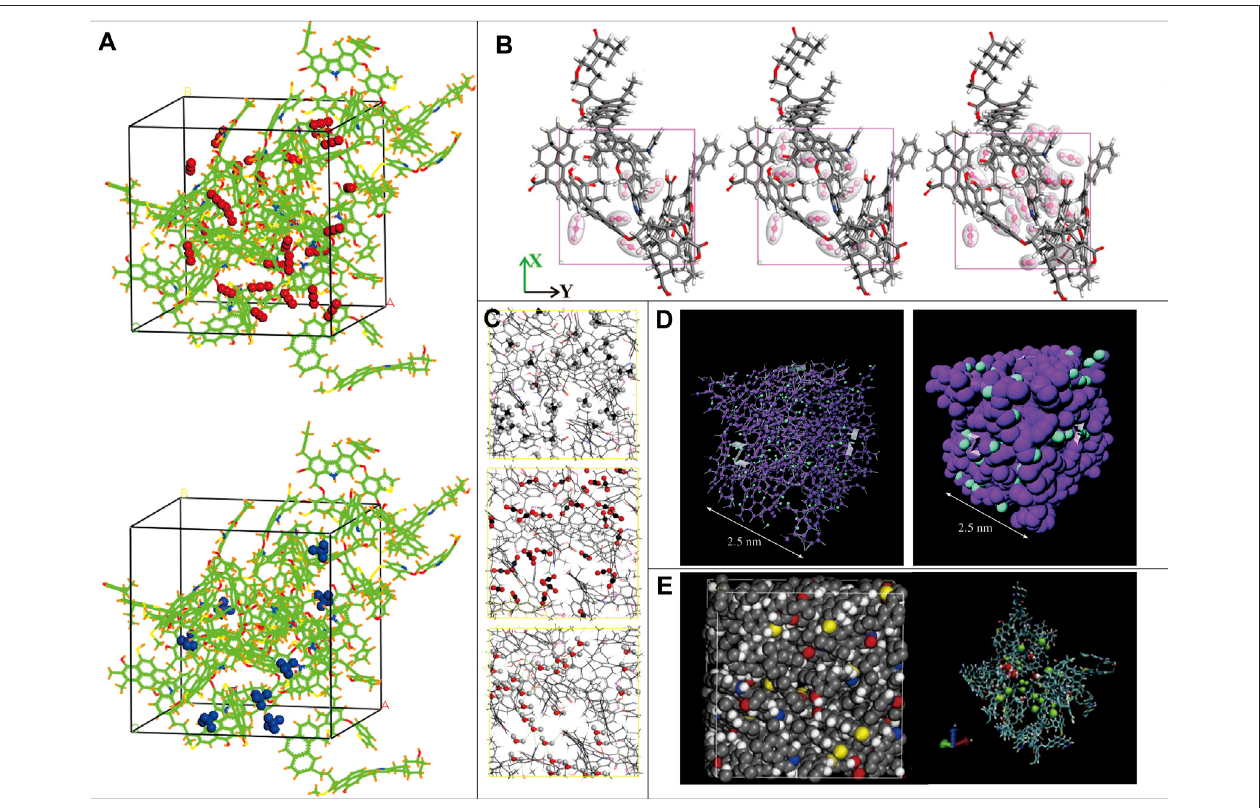
FIGURE 5 | Typical coal macromolecular representations used to simulate the adsorption process (A) : Wiser model absorbing the CO 2 and CH 4 (Zhao et al., 2016b); (B) : the typical vitrinite model absorbing different amounts of CO 2 (Song et al., 2018); (C) : the Yanzhou coal model absorbing CH 4 , CO 2 , and H 2 O (Xiang et al., 2014); (D) : CS1000 coal model absorbing CO 2 (Brochard et al., 2012); (E) : intermediate-rank bituminous coal building block absorbing H 2 O and CH 4 (Zhang et al., 2014).